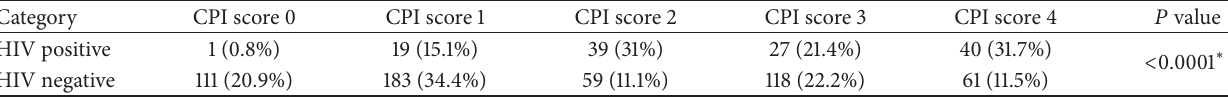
Table 4: CPI scores (community periodontal index) between HIV positive and negative groups.